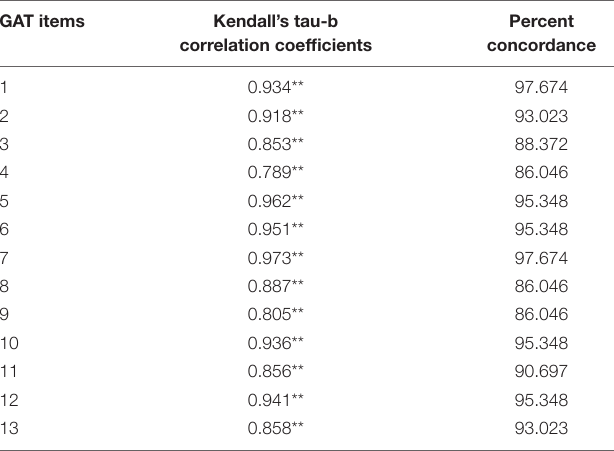
TABLE 5 | Kendall correlation and percent concordance between raters’ ranking for Grounding Assessment Tool (GAT) scores ( n = 20). GAT items